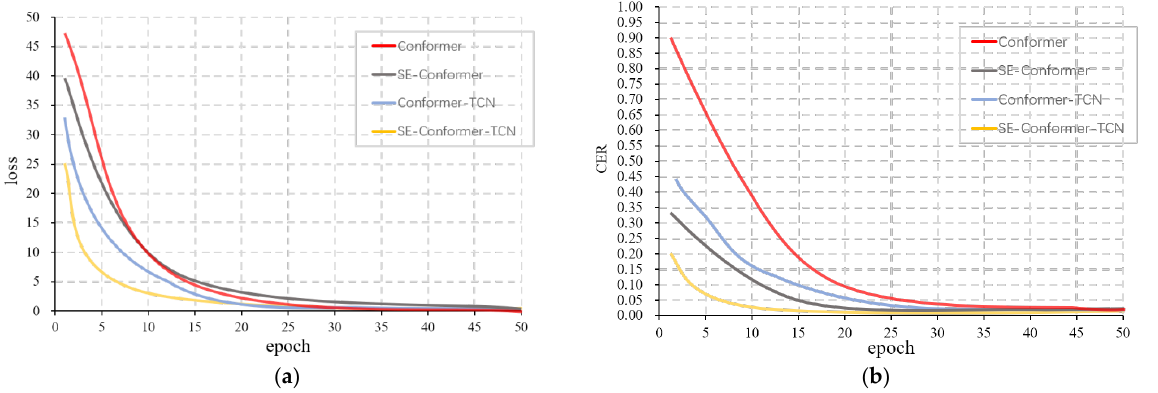
Figure 6. Convergence process for four experimental models. ( a ) Loss convergence process; ( b ) CER convergence process.